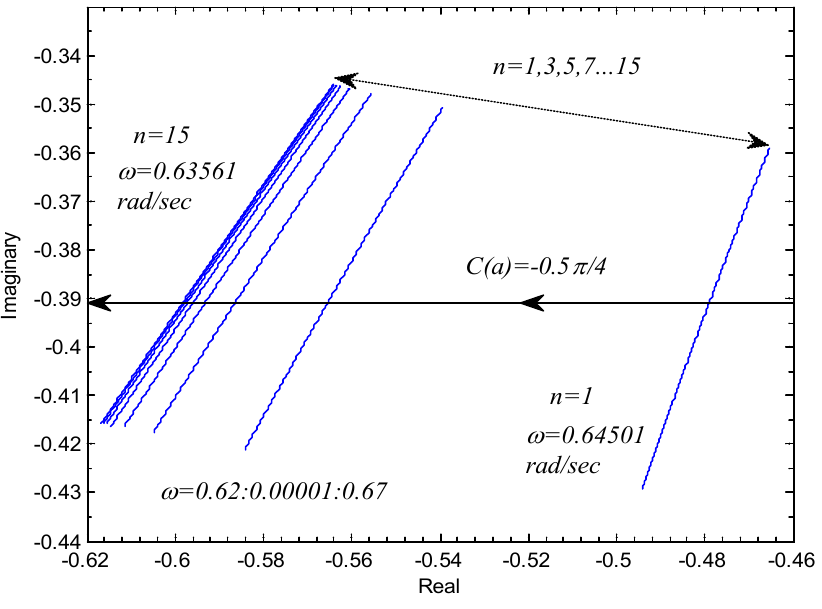
Figure 11. A Loci for different values of n for Equation (34) where